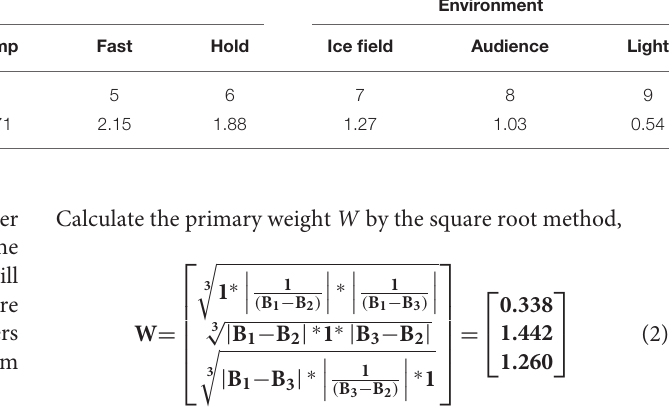
TABLE 1 | Ontology and keyword sorting number labeling. Object